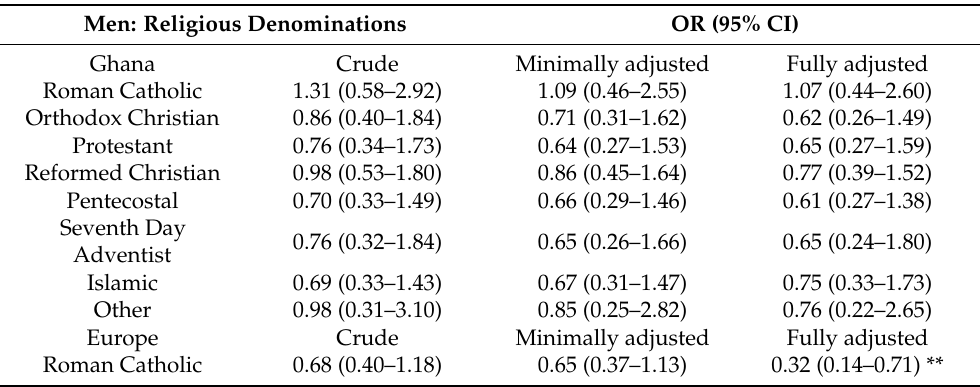
Table 4. Odds ratios for estimated elevated ( ≥ 7.5%) 10-year CVD risk for religious denominations compared with not practicing a religion, stratified by sex and